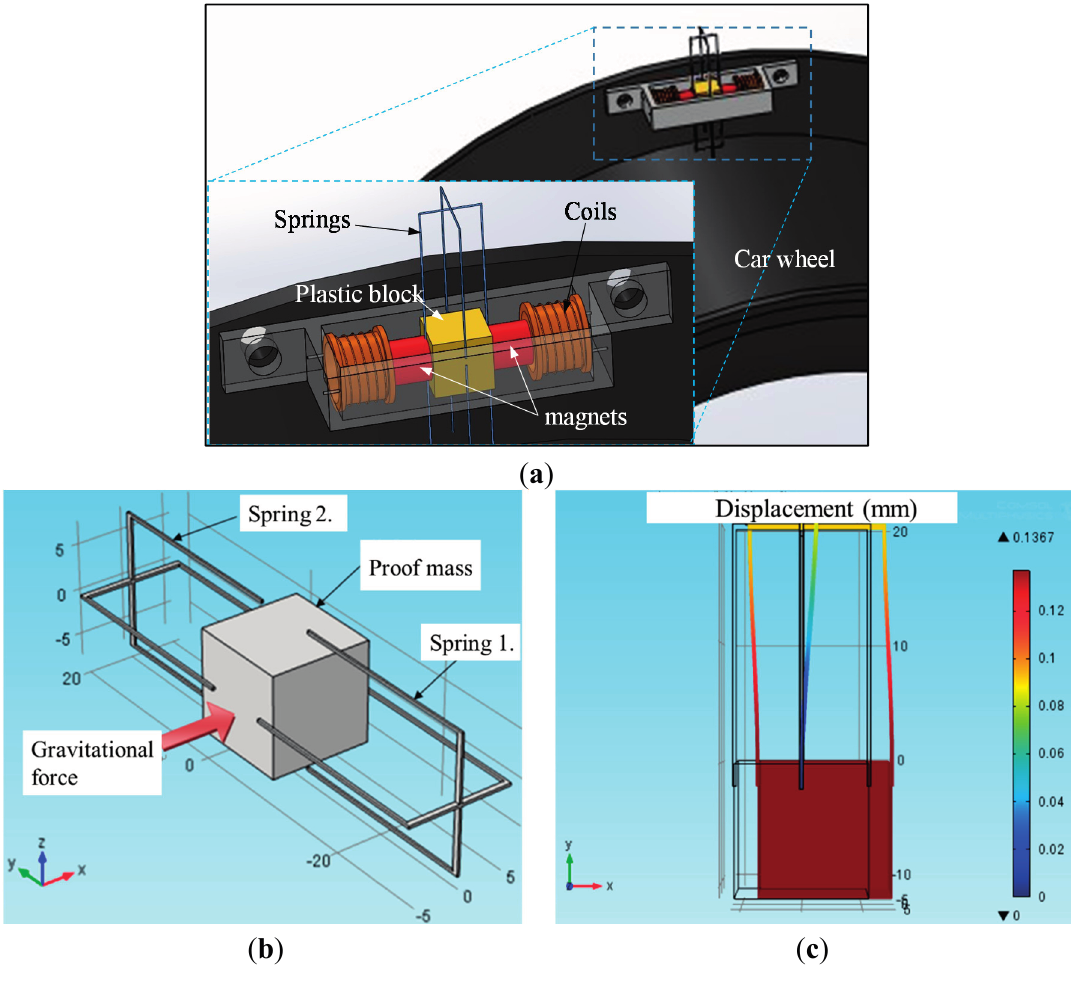
Figure 5. Displacement simulation of the prototype by using COMSOL Multiphysics 4.2. ( a ) Schematic diagram of the NSEH mounted on a car wheel. ( b ) Detailed structures and force load. ( c ) Half display of the displacement simulation